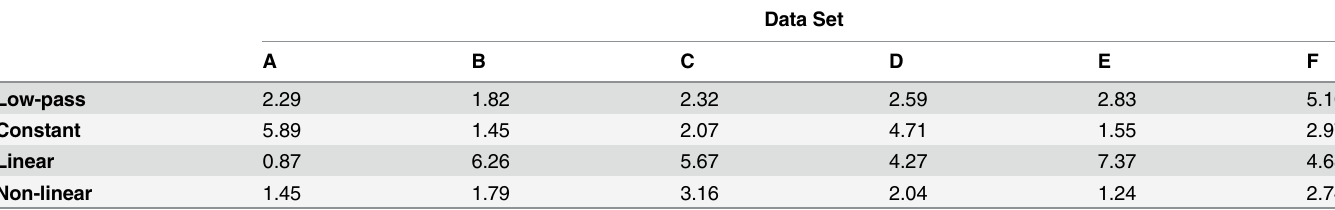
Table 5. Standard deviation of the estimated response duration produced by the different